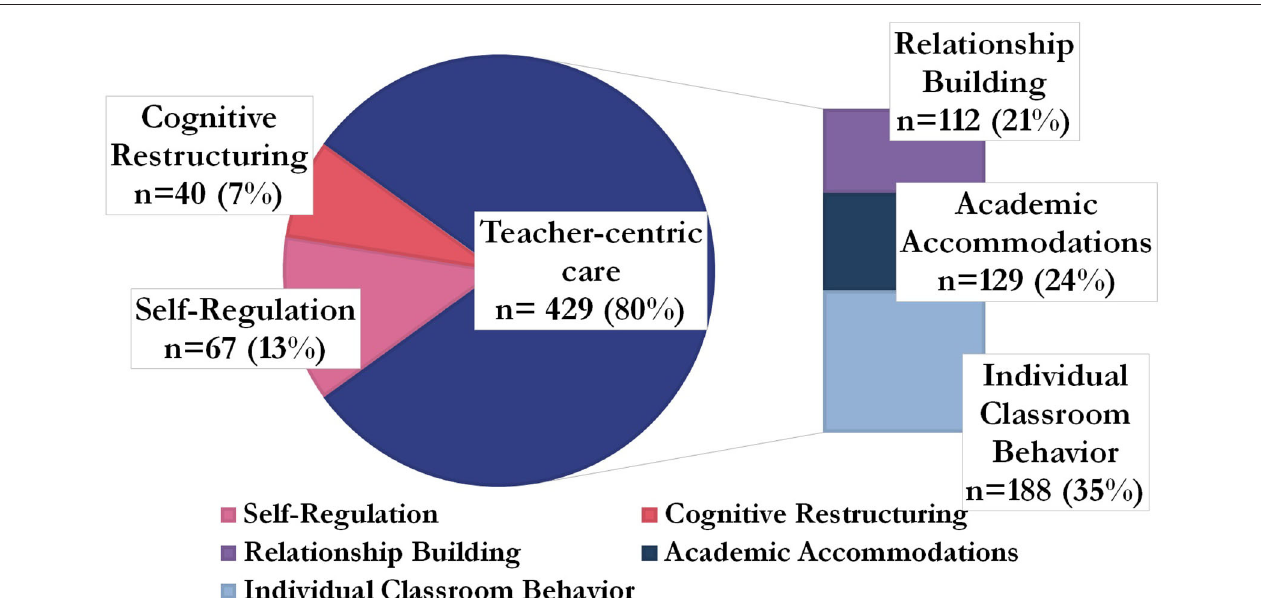
FIGURE 4 | Categories of therapeutic techniques teachers used, grouped by teacher-centric care n = 536.